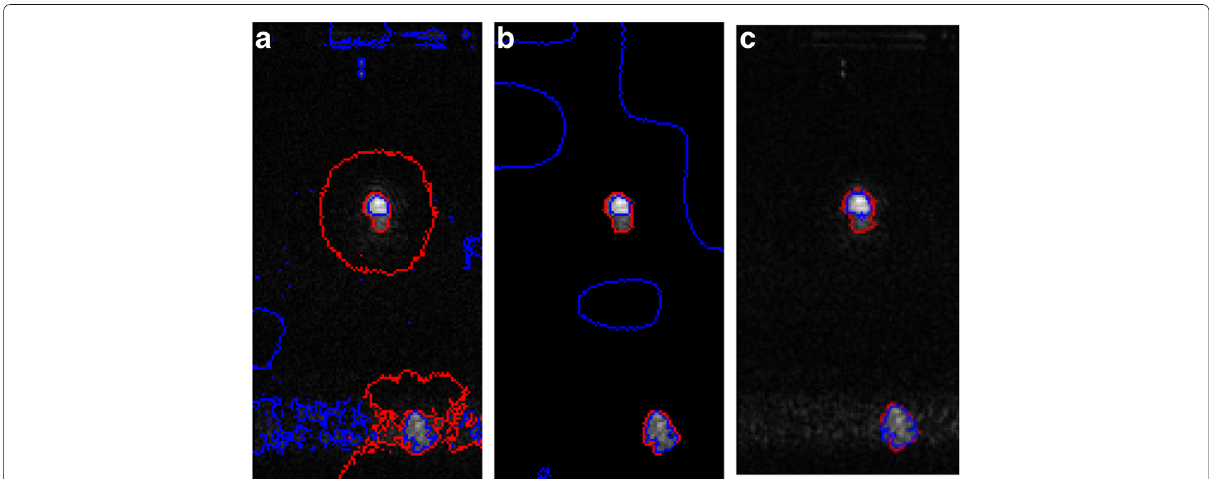
Fig. 1 Inaccurate curve evolution by Li et al.’s [31] method with background noises: a Final contours without background noise suppression. b Contours after background noise removal. c Contours by our